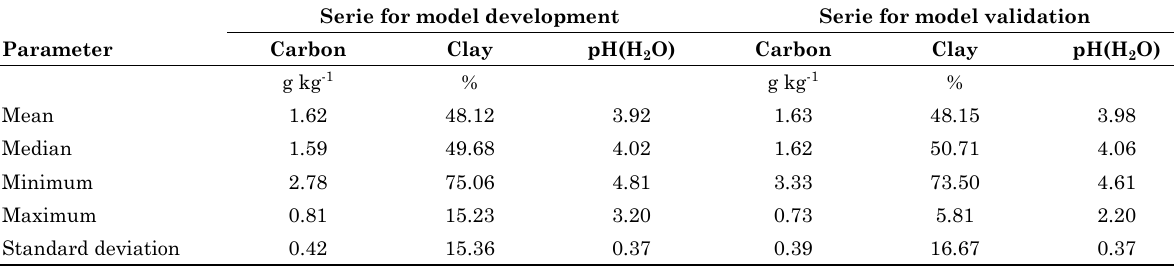
Table 1. Descriptive statistics for the model parameters Serie for model